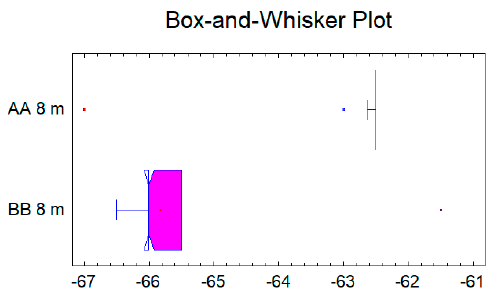
Figure 11. Box-and-whisker plot for reading distance 8 m.